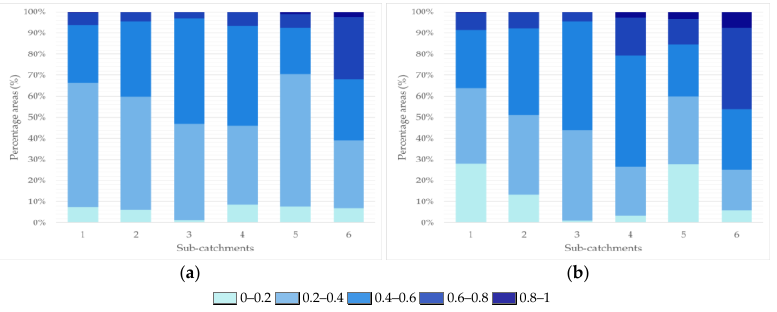
Figure 10. Percentage of area in sub-catchments 1–6 falling within the different runoff indicator (RoI) classes in ( a ) 1997 and ( b ) 2017.